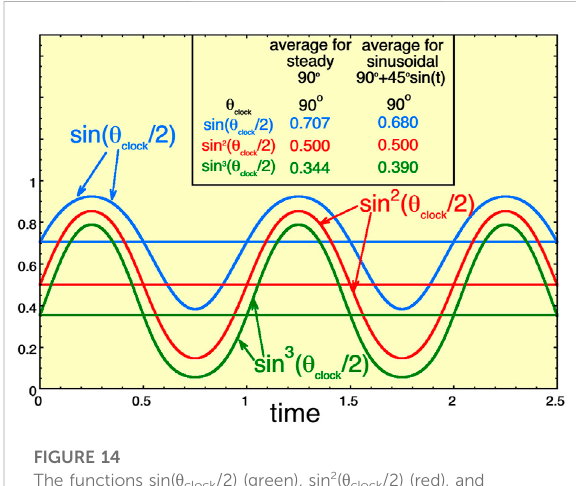
FIGURE 14 The functions sin( θ clock /2) (green), sin 2 ( θ clock /2) (red), and sin 3 ( θ clock /2) (blue) are plotted as functions of time for the steady 90 o clock angle and for the sinusoidally oscillating clock angle 90 o + 45 o sin(t). The table in the fi gure lists the average values for the steady 90 o clock angle and for the sinusoidal 90 o + 45 o sin(t) clock